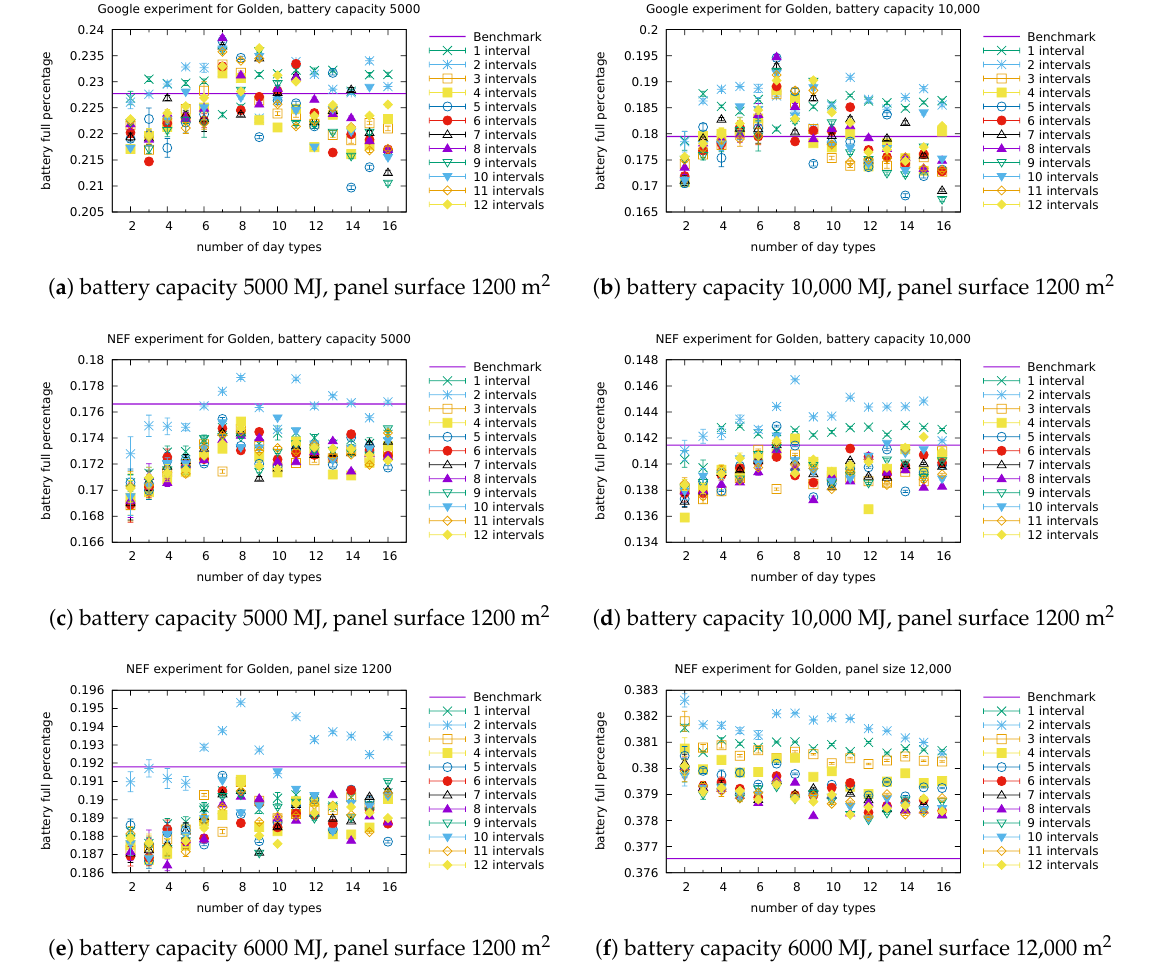
Figure A4. Full ratio, Golden: Detailed performance of our model for several settings of the battery capacity and panel surface with Google consumer ( a , b ) and NEF consumer ( c – f ).